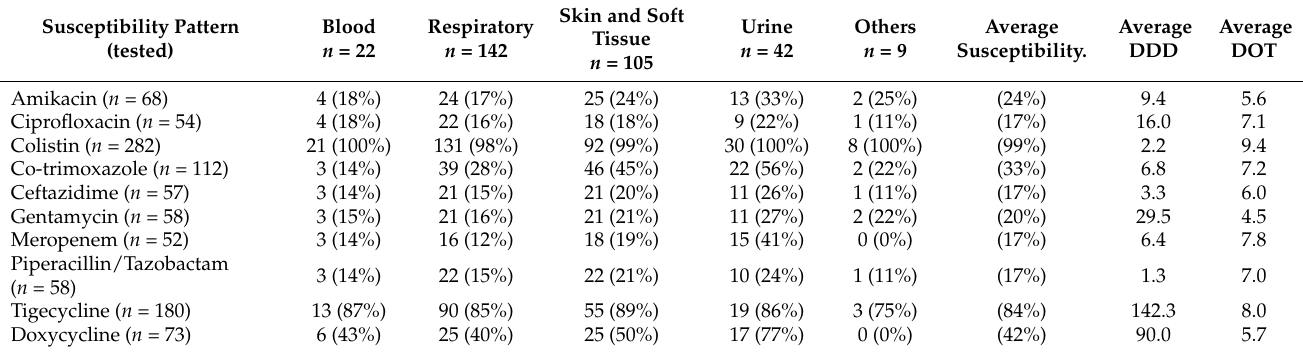
Table 1. Susceptibility pattern and antibiotic use